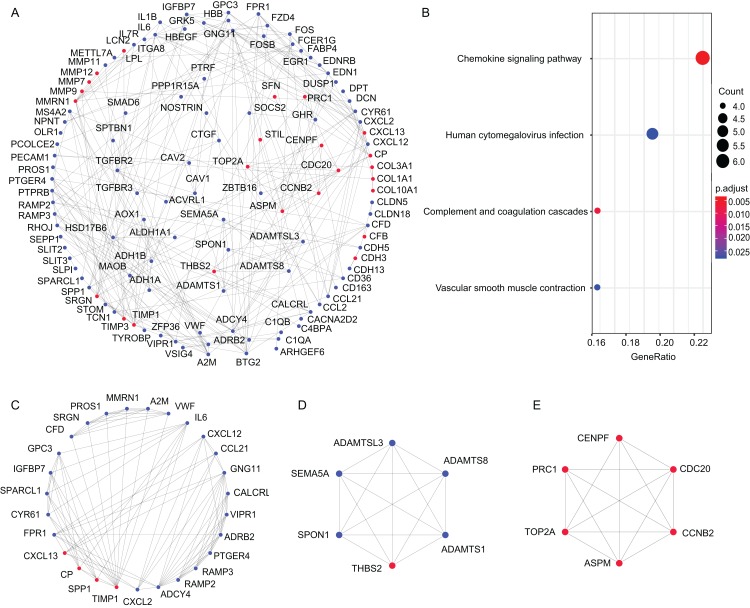
Protein–protein interaction network of DEGs and modules analysis.(A) PPI network of DEGs; (B) The KEGG enrichment analysis of the genes in the top three modules. (C–E) the top 3 modules of PPI network. The red nodes represent the upregulated DEGs. The blue nodes represent the downregulated DEGs. PPI, protein–protein interaction; DEG, differentially expressed gene; KEGG, Kyoto Encyclopedia of Genes and Genomes.